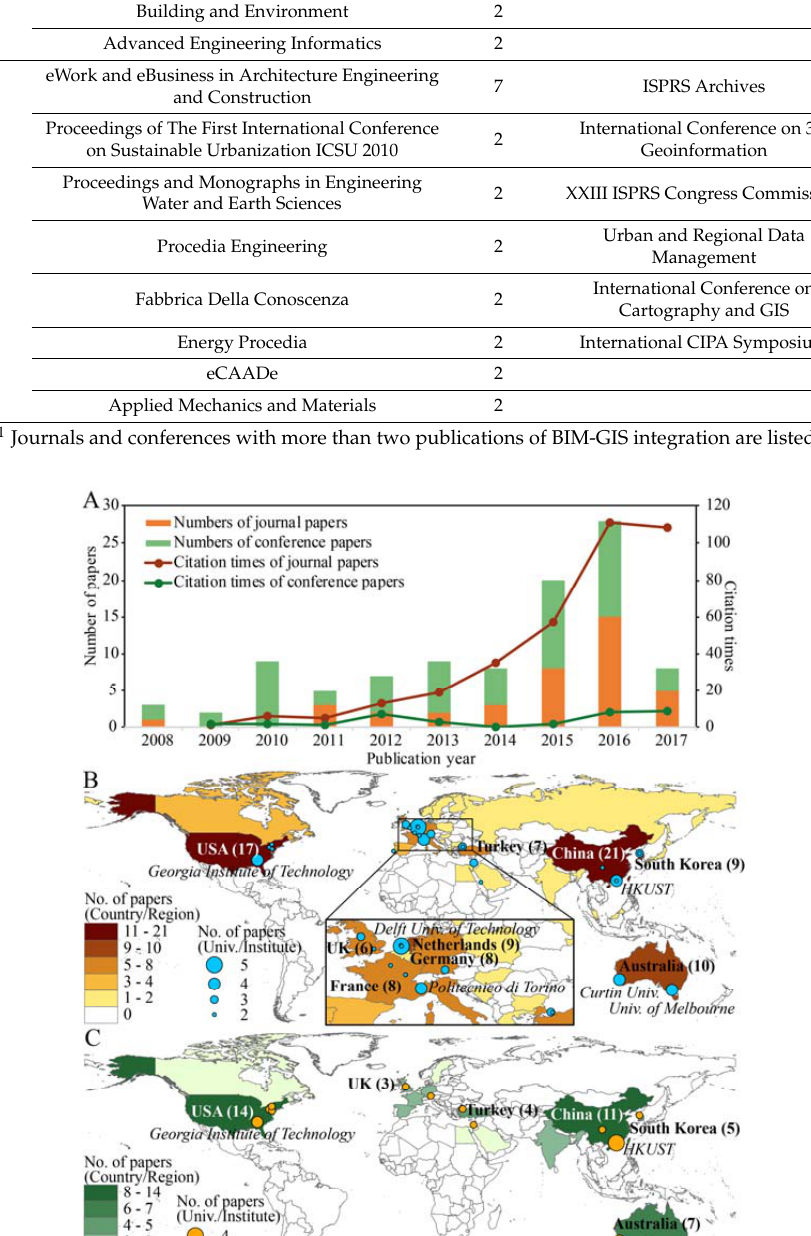
Table 2. Summary of journals and conferences for the publications of BIM-GIS integration.